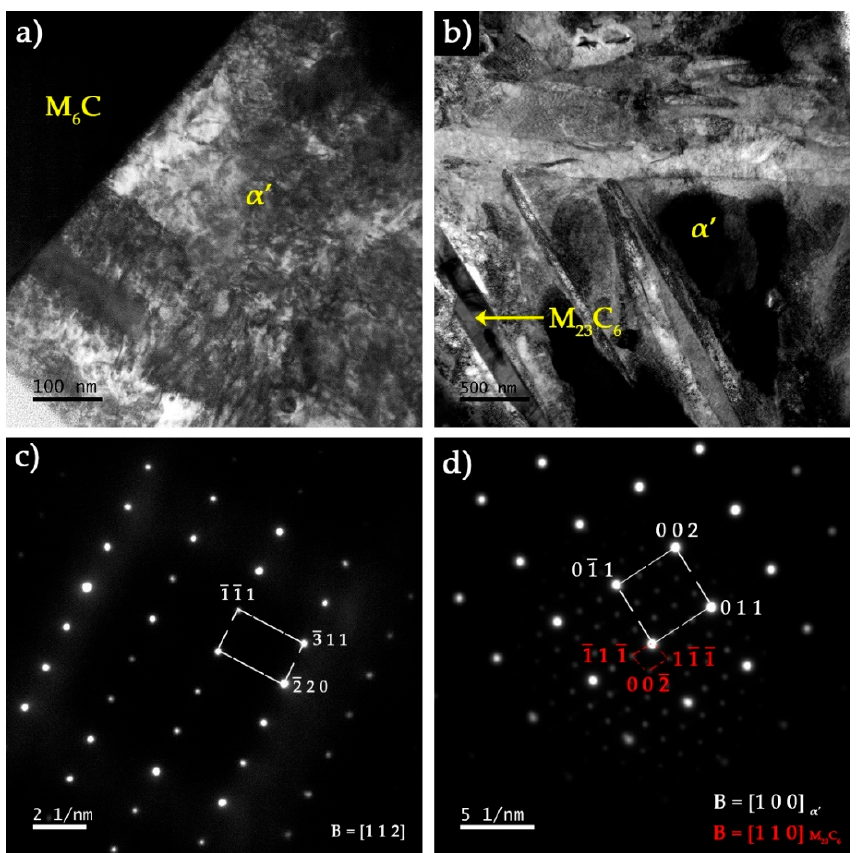
Figure 18. SEM-BSE images of the microstructure of the composite zone, ( a ) a detailed of a eutectic constituent (Fe,Cr) 7 C 3 and (Fe,W,Cr) 6 C + α ’) and ( b ) the martensite phase.